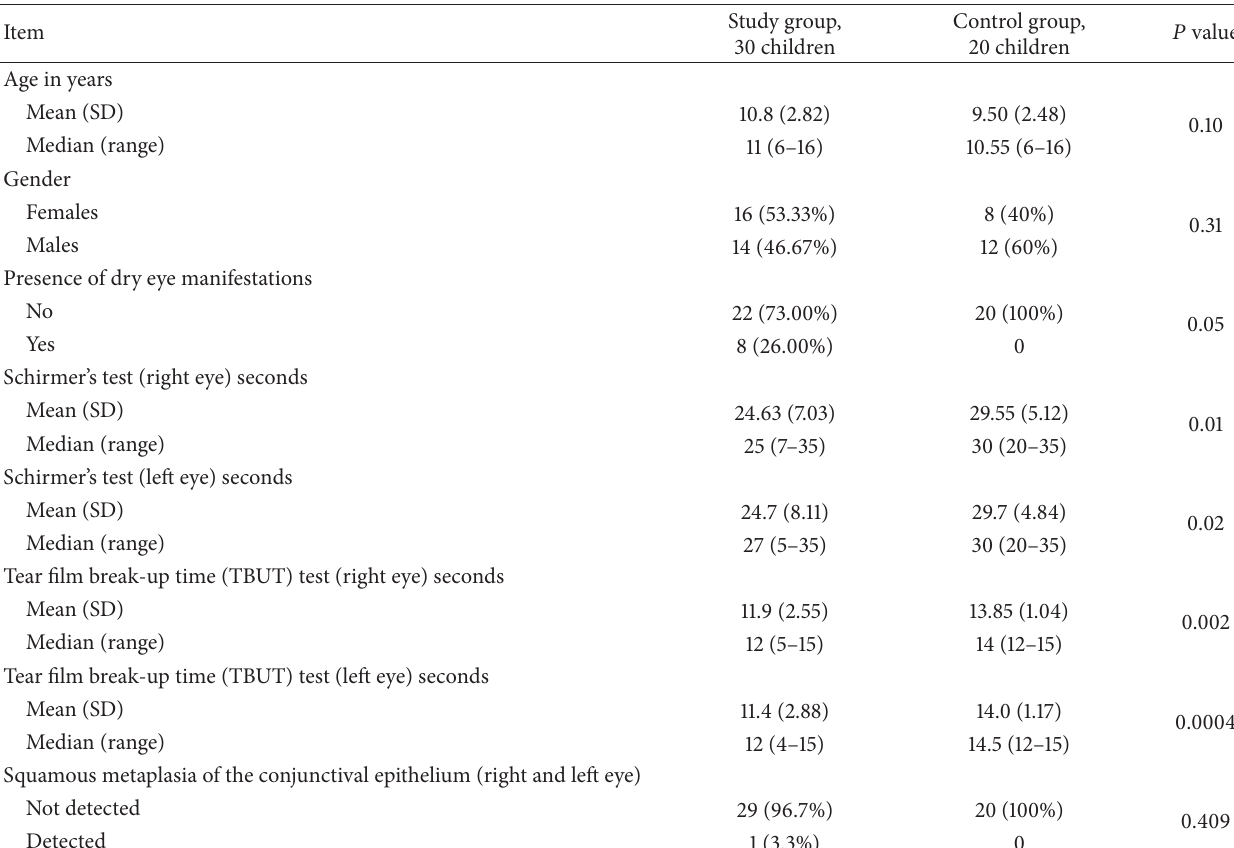
Table 3: Comparison between study and control